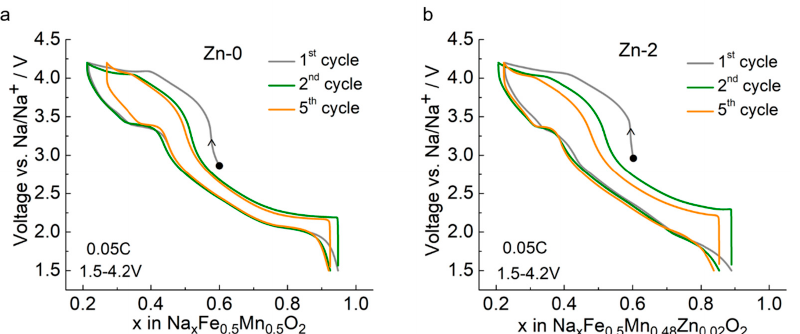
Figure 7. Galvanostatic cycling curve plotted as a function of Na content (x) in ( a ) Zn-0 and ( b ) Zn-2 cathode cycled between 1.5 to 4.2 V vs. Na/Na + at 0.05 C. The starting point of the measurement is marked (•).